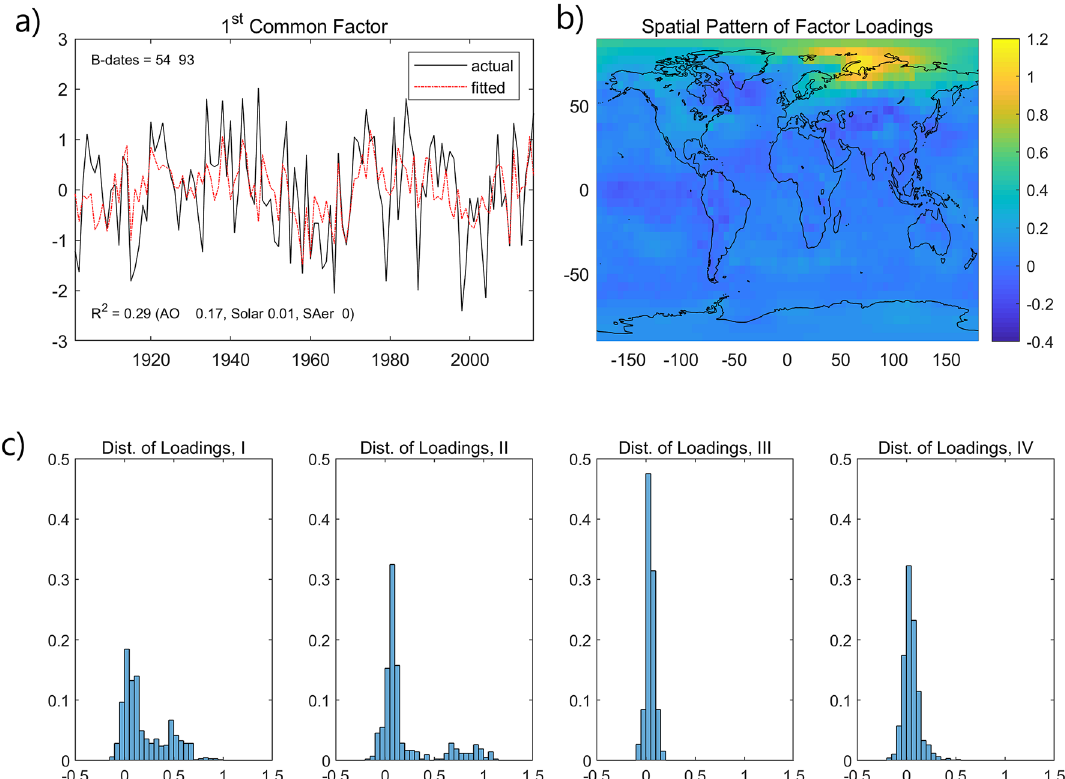
Figure 3. Time series and spatial pattern of the common factor with annual temperatures. The solid black line in ( a ) plots the common factor and the red dash-dot line is the fitted line from a regression of the common 2 factor on a constant, AO and forcing factors (see “Methods”). The R is 0.29 and the numbers in parenthesis are 2 the marginal R values of the three most significant regressors. ( b ) Displays the values of the factor loadings in a color map. ( c ) Shows the distribution of the loading values for each of the four cases, I ~ IV in Fig. 1. This figure was created using MATLAB R2018a (https ://www.mathw